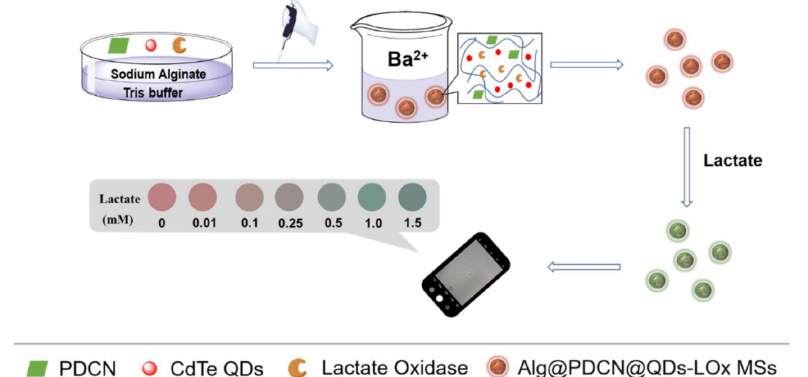
Figure 1. Schematic of the synthesis of Alg@PDCN@QDs-LOx MSs and their application in the detection of